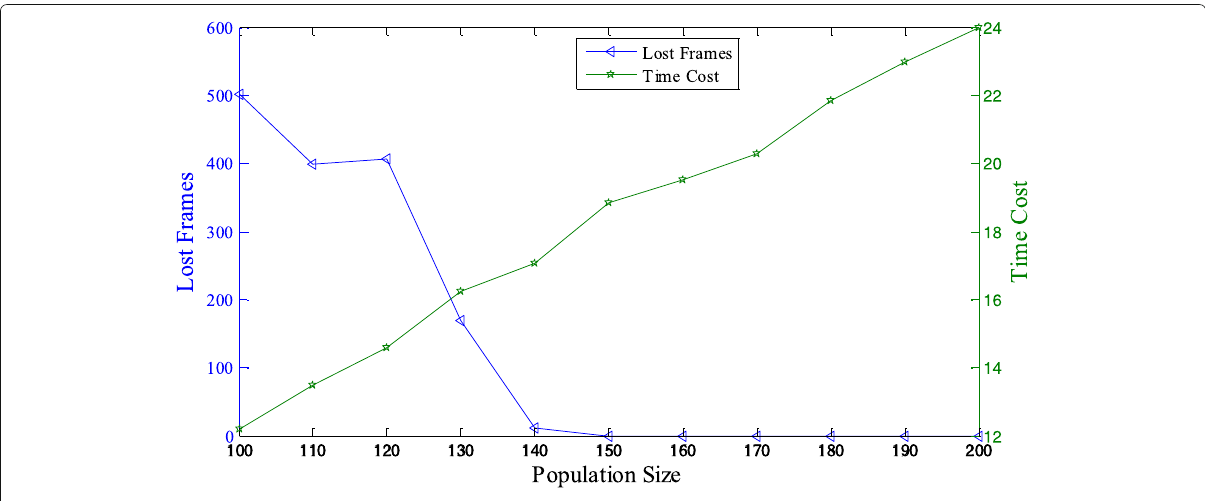
Fig. 6 Performance comparison with different population size Np parameters P can track by the tracker except for P = 0.3 at frame #0085. Only the selected parameters P = 0.5 and P = 0.1 can track the target at frame #0115, and P = 0.5